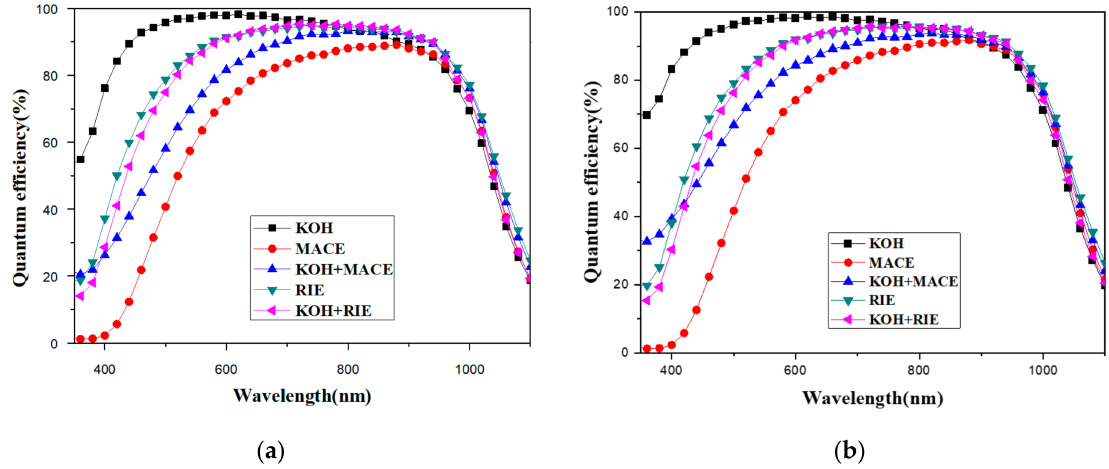
Figure 15. Quantum efficiency characteristics according to various etching process methods: ( a ) external and ( b )